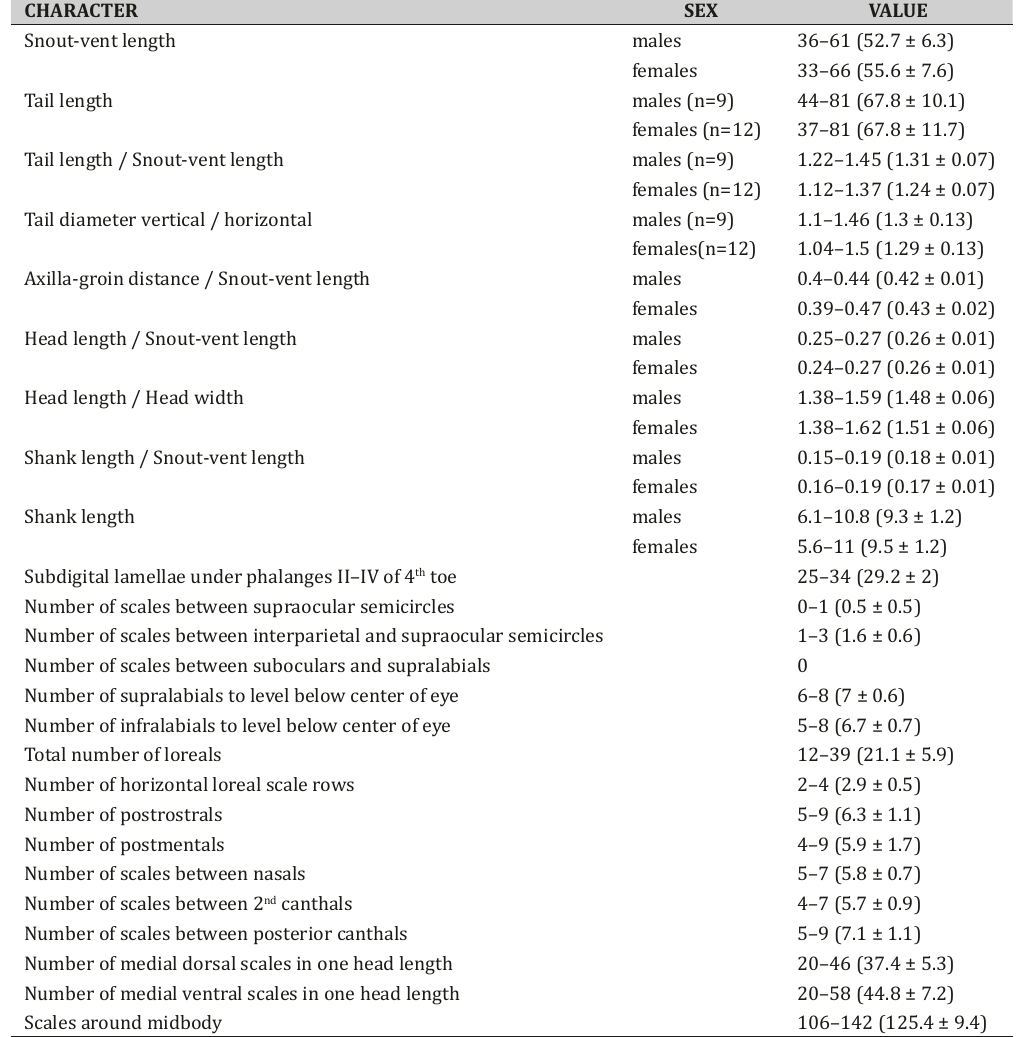
Table 1 . Selected measurements, proportions, and scale characters of 12 males and 16 females (n=28) of and standard deviation in parentheses. CHARACTER